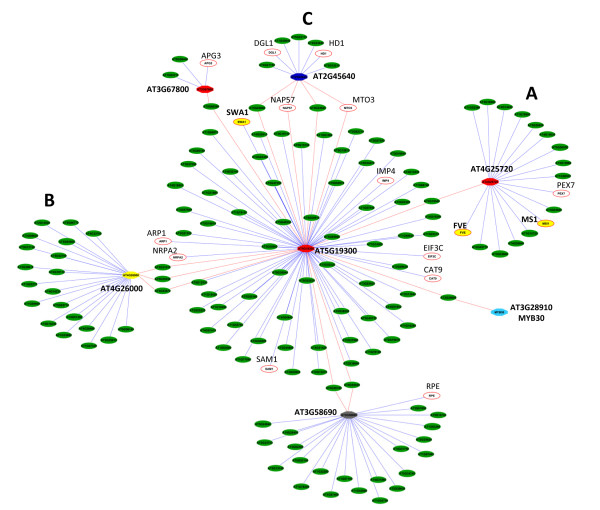
Prediction of the extended regulatory network of genes that are negatively correlated with BvRAV1-like. The network was based on analysis of homologous Arabidopsis proteins and constructed using AraNet at http://www.functionalnet.org/aranet Red nodes are unknown, yellow nodes are associated with reproductive growth; grey node is associated with protein modification; dark blue node with histone modification and the light blue node with hormonal signalling. White nodes with red outline represent loci of known genes with GO terms associated with processes including cold regulated biosynthesis (MTO3); amino acid/protein transport (PEX7, CAT9); translation, rRNA processing/biogenesis (EIF3C, IMP4, HD1, NRPA2, APG3, NAP570; ethylene induced biosynthesis (SAM1) embryonic development leading to seed dormancy (ARP1, RPE) and cell wall biogenesis (DGL1). MTO3 = Methionin Over-Accumulator 3; PEX7 = Peroxin 7; CAT9 = Cationic amino Acid Transporter 9; EIF3C = Eukaryotic translation initiation Factor 3 C; HD1 = Histone Deacetylase 1; NRPA2 = DNA binding/DNA-directed RNA polymerase/ribonucleoside binding; APG3 = Albino and Pale Green; SAM1 = S-Adenosylmethionine Synthetase 1; ARP1 = Arabidopsis Ribosomal Protein 1, RPE = Ribulose Phospate 3-Epimerase; DGL1 = dolichyl-diphosphooligosaccharide-protein glycotransferase.